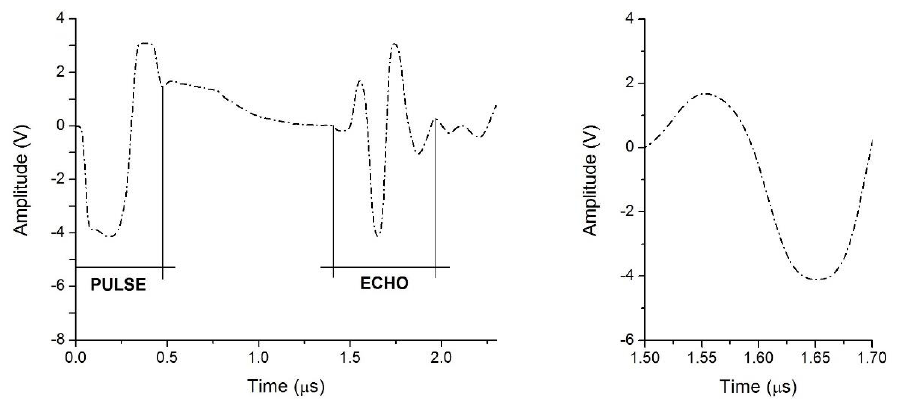
Figure 8. UT signals versus time, corresponding to 1st test on point 1 of undamaged specimen (D 0 ). ( Left ) Pulse and echo of full signal, ( Right ) Main Wave (MW).